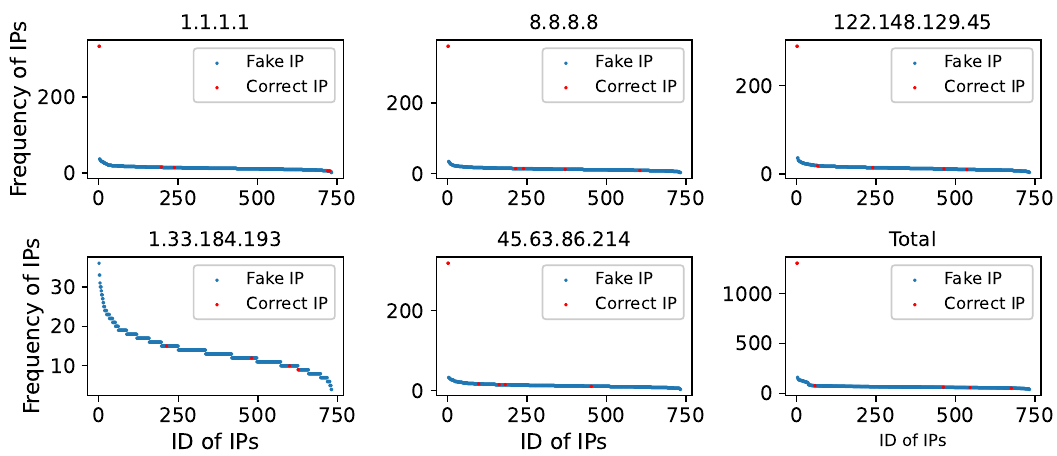
Figure 17. The frequency with which non-Chinese pDNS respond to correct and forged IPs for the domain theporndude.com.